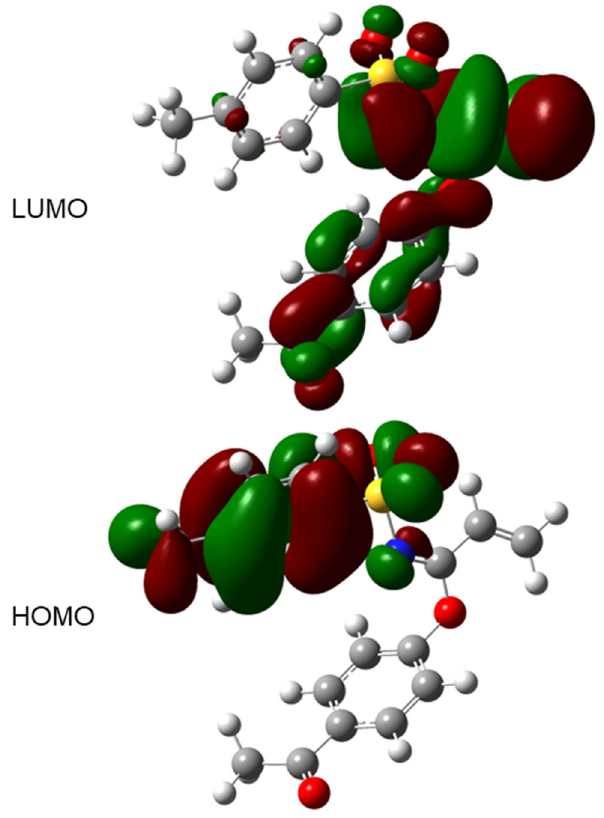
Figure 10. LUMO and HOMO plot (iso-surface 0.02 a.u.) for 3 calculated at PBE1PBE/cc-pVDZ level of theory.